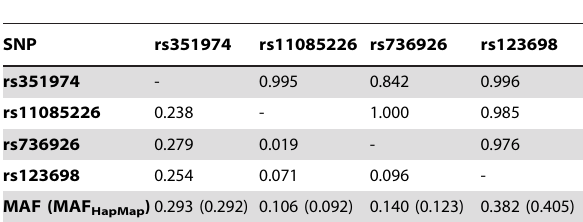
Table 2. Linkage disequilibrium statistics (D 9 , r 2 ) among the four tagging SNPs rs351974, rs11085226, rs736926, and rs123698 covering the 14.92 kb genomic locus harbouring the PTBP1